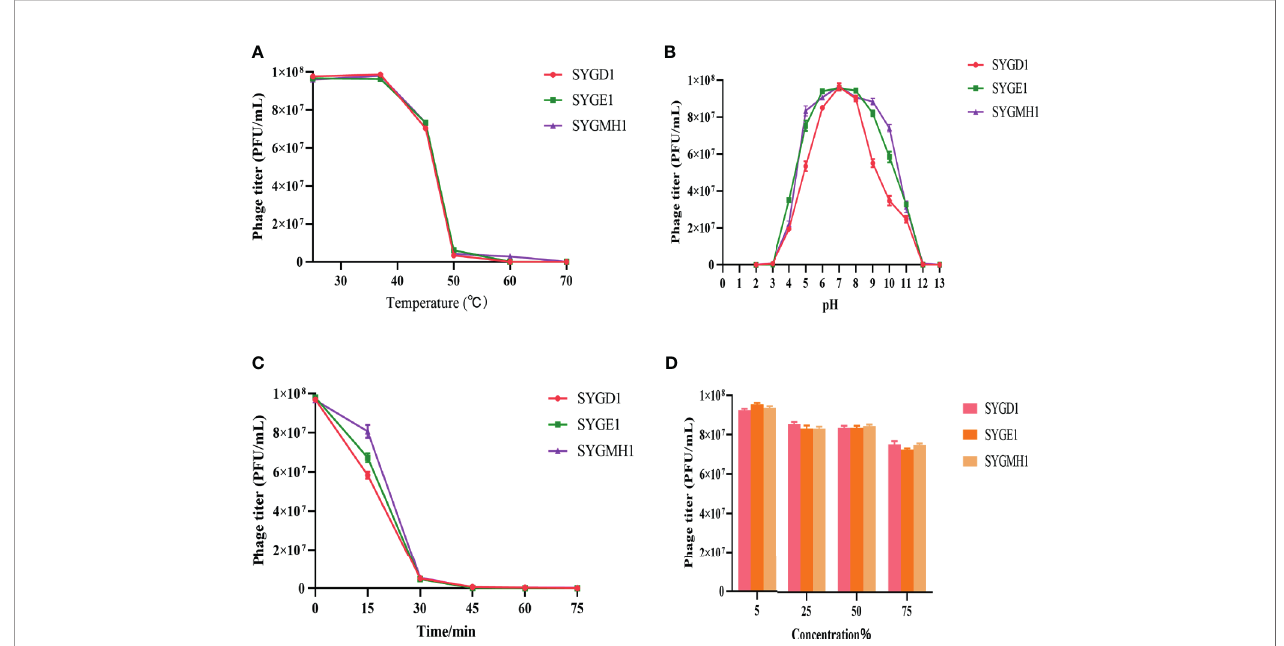
FIGURE 4 | Stability of vB_EcoM_SYGD1, vB_EcoP_SYGE1, and vB_EcoM_SYGMH1 under various conditions. (A) Temperature. (B) pH stability. (C) UV radiation stability. (D) Chloroform sensitivity. Survived phage particles were determined by double-layer tests. Error bars show the SEM among triplicate samples.